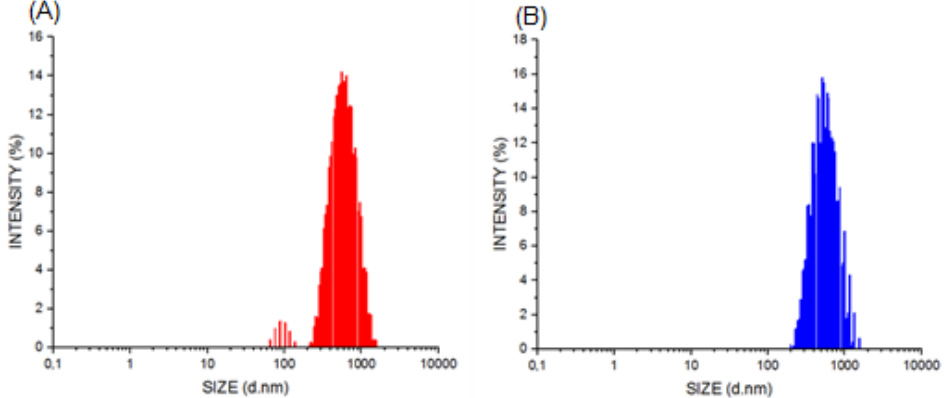
Figure 2. Distribution of PN’s size by intensity analyzed by DLS: EMP-PN ( A ) and PG-PN ( B ).